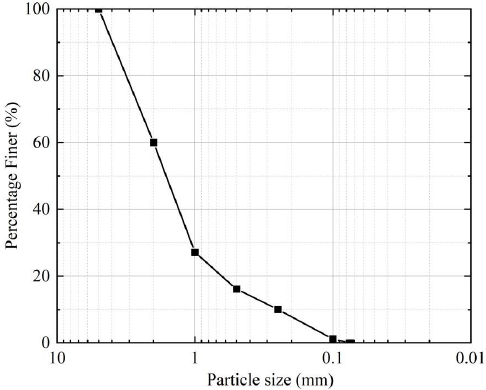
Figure 4. Particle gradation curve.